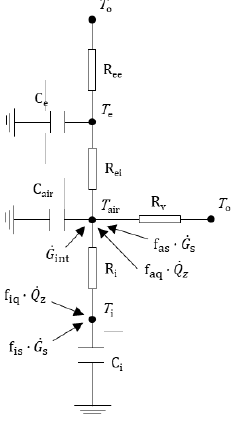
Figure 3. Third-order RC network building model.